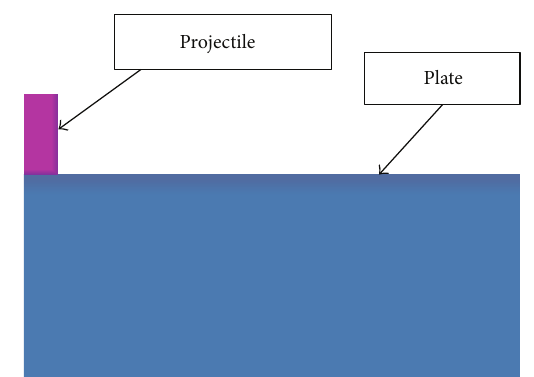
Figure 10: A typical CTH model with 0.10mm × 0.10 mm zone (zoomed